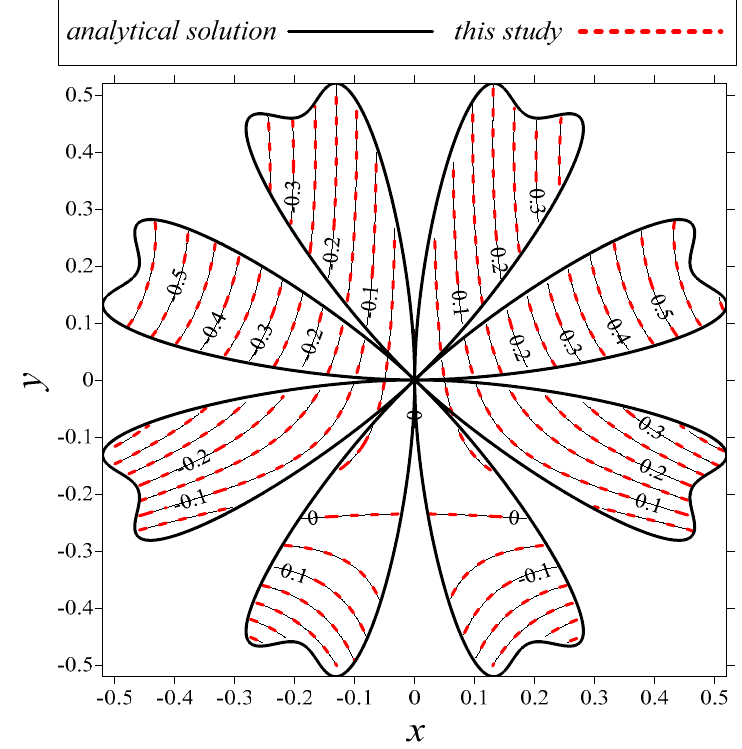
Figure 10. Results comparison between this study and the analytical solution.